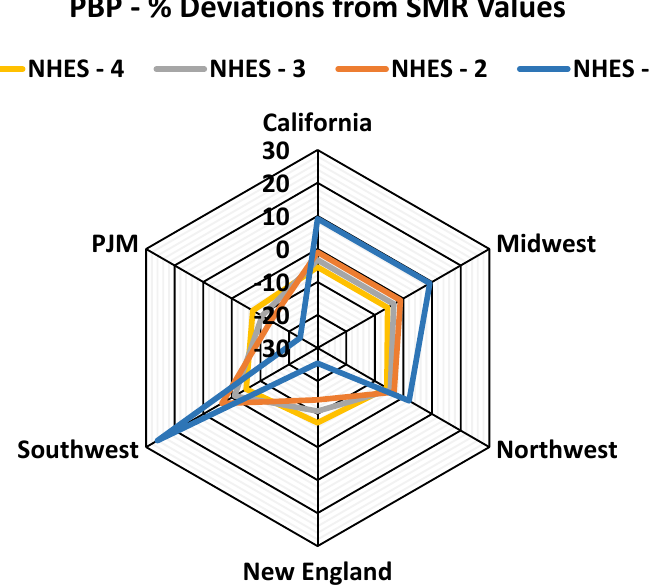
Figure 9. Percentage deviation of PBP for different NHES scenarios from SMR values.